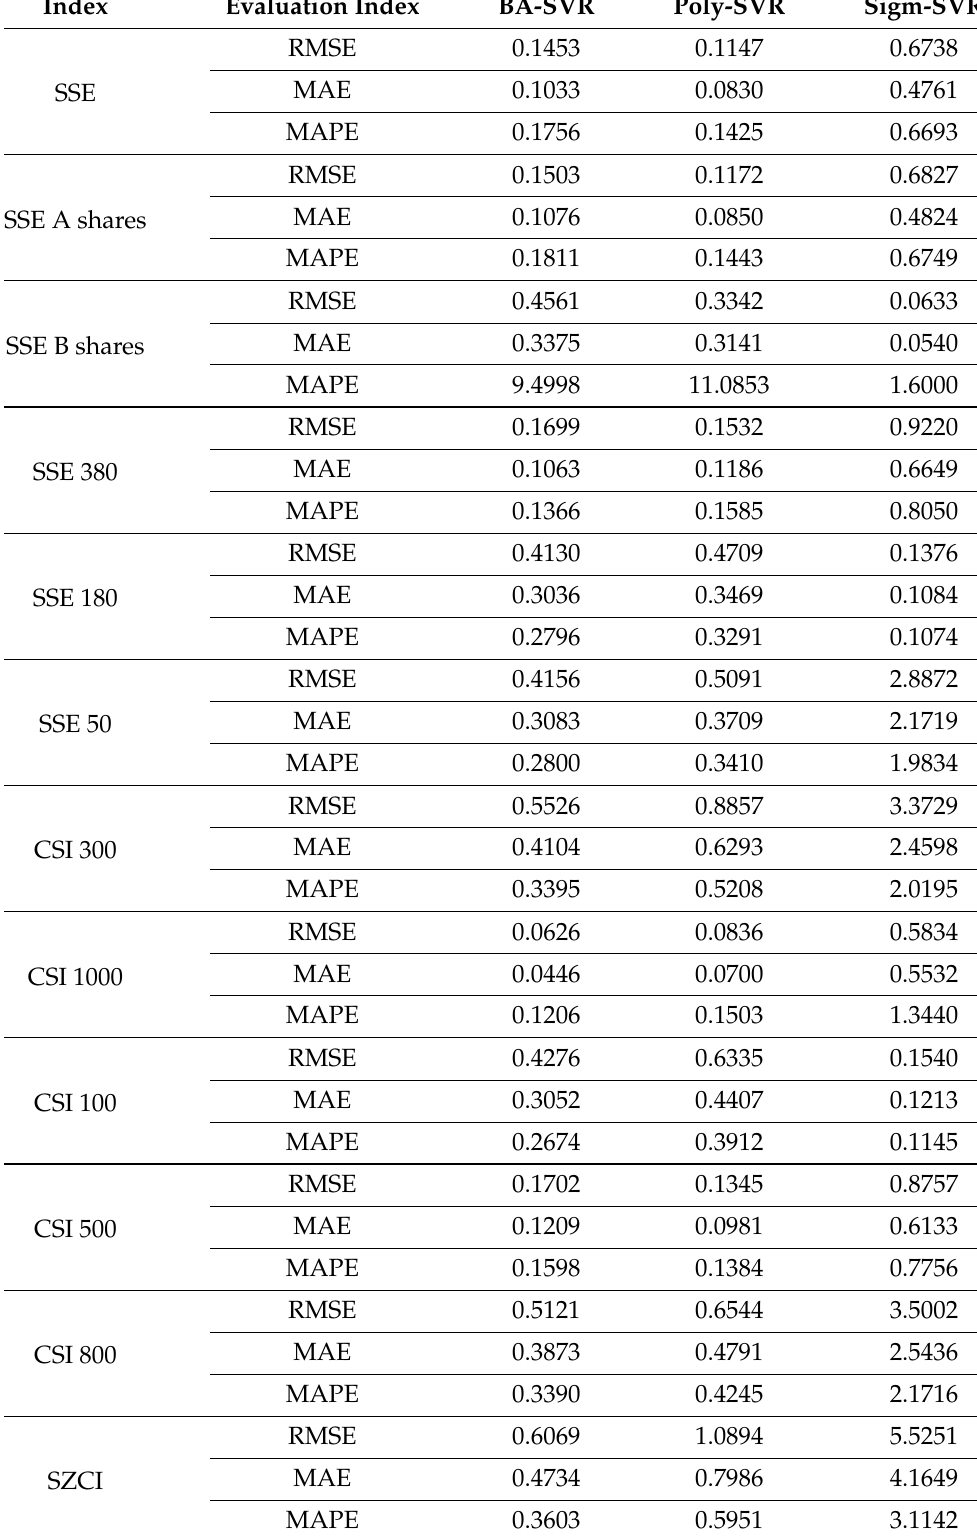
Table 12. The 250-day long-term forecast effect of 18 stock